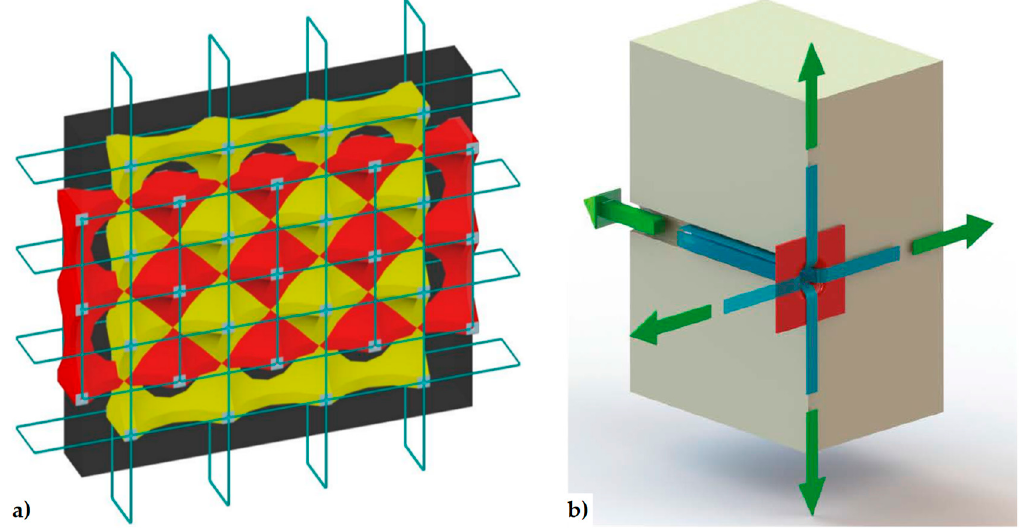
Figure 21. Retrofitting design of a masonry wall by the CAM system: ( a ) the internal stress-field assumed in [52,64]; ( b ) forces acting on one node of the CAM net, provided by the straps that pass through a common drilled hole [52].